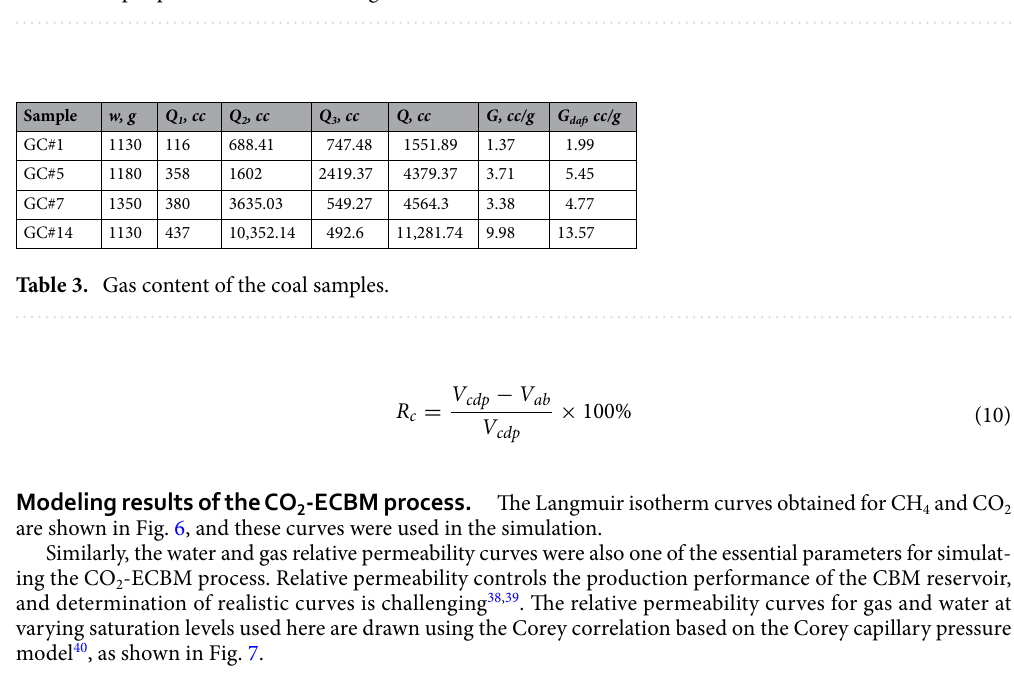
Table 2. Input parameters for modeling.